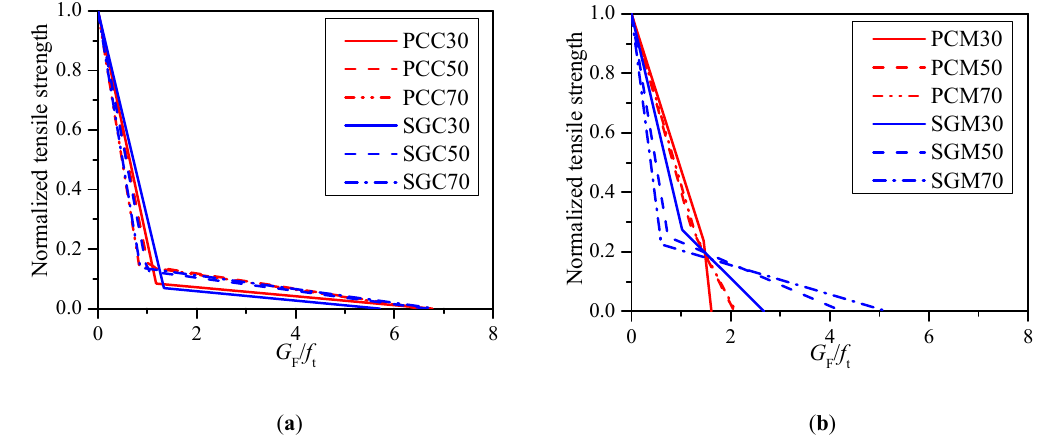
Figure 3. Bilinear softening laws of the PC and SG concrete and mortar. ( a ) PCC and SGC and ( b ) PCM and SGM.